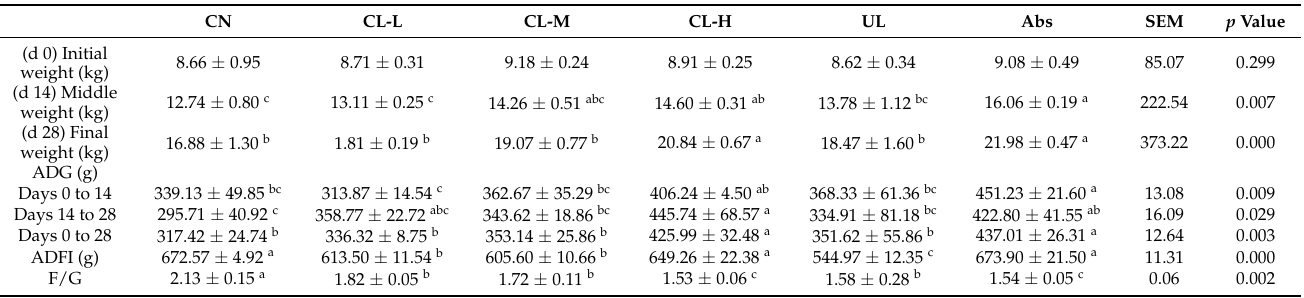
Table 1. Effects of the CN, CL-L, CL-M, CL-H, UL, and Abs dietary interventions on the growth performance of piglets.